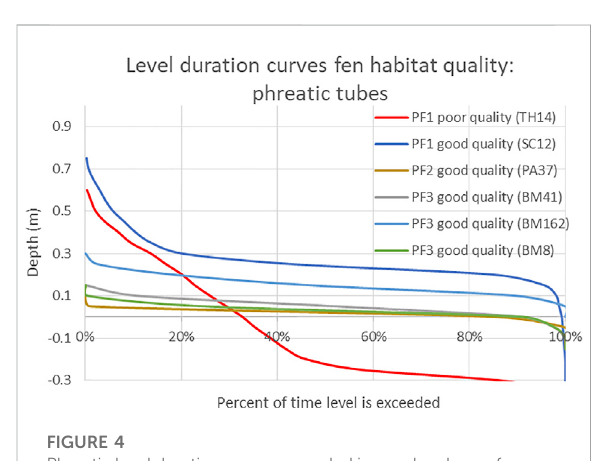
FIGURE 4 Phreatic level duration curves recorded in good and poor fen